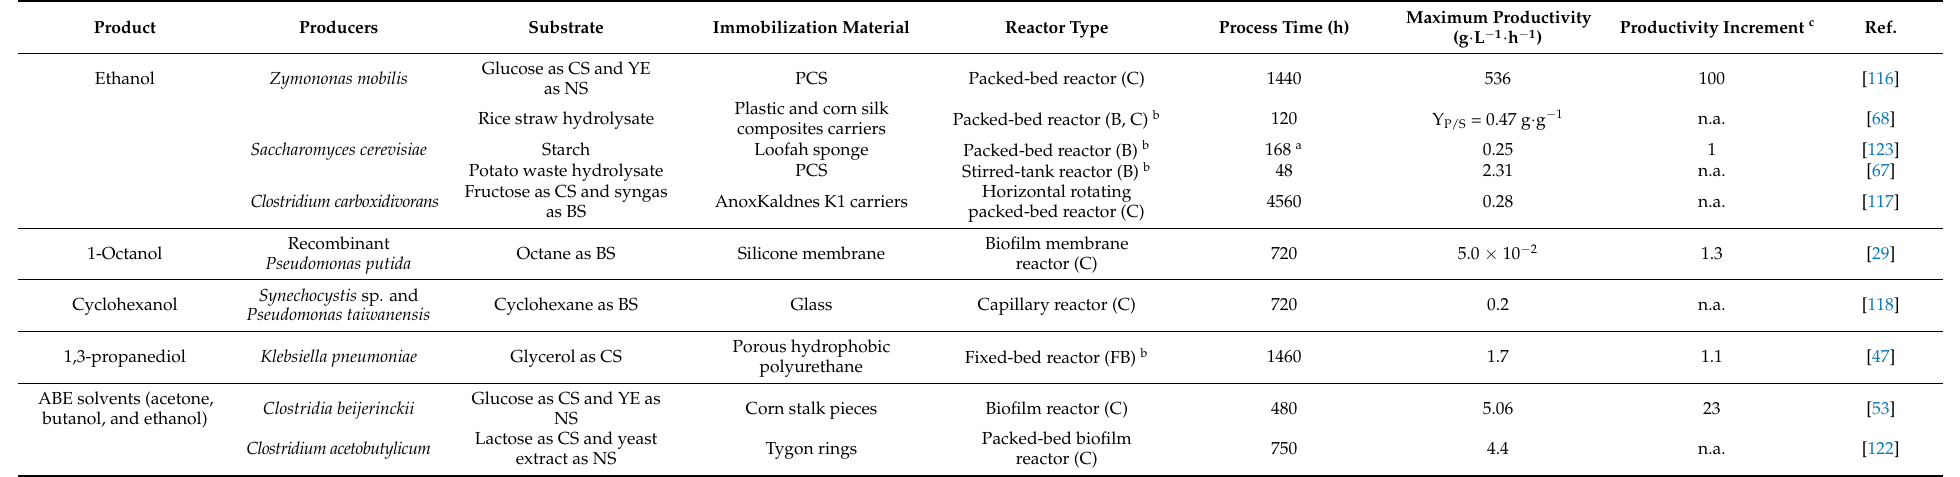
Table 5. Different classes of alcohols and solvents produced in biofilm